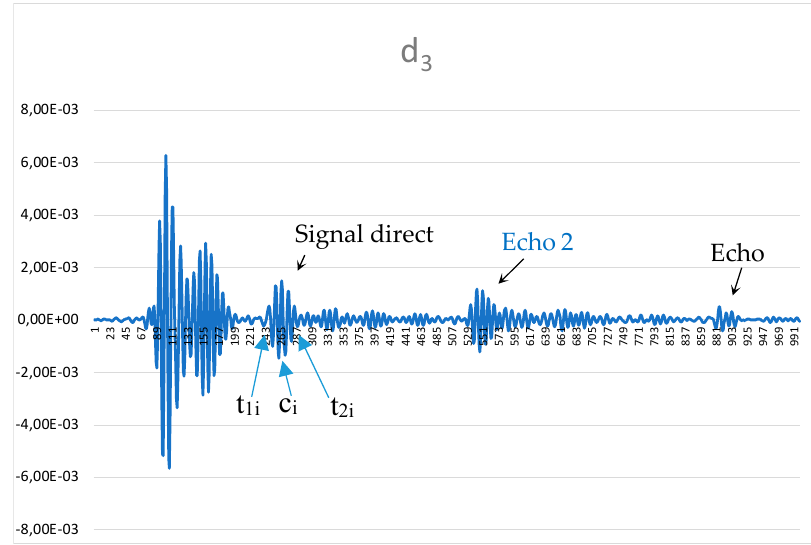
Figure 22. Signal obtained from the wavelet transformation [V/div].